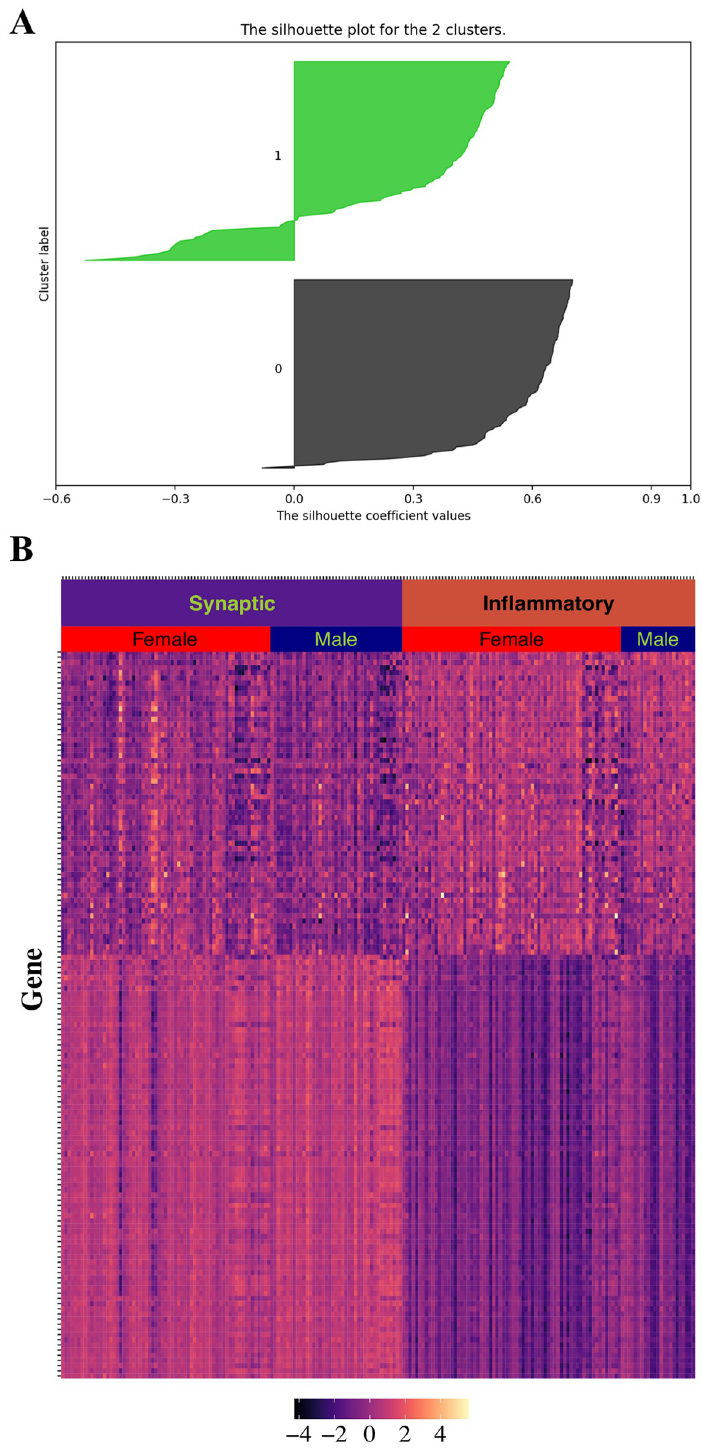
Fig 4. Signature genes in each molecular subtype. (A) Silhouette score for each sample (B) Heatmap for signature gene expression in each molecular subtype. Gene expression is represented as normalized value.